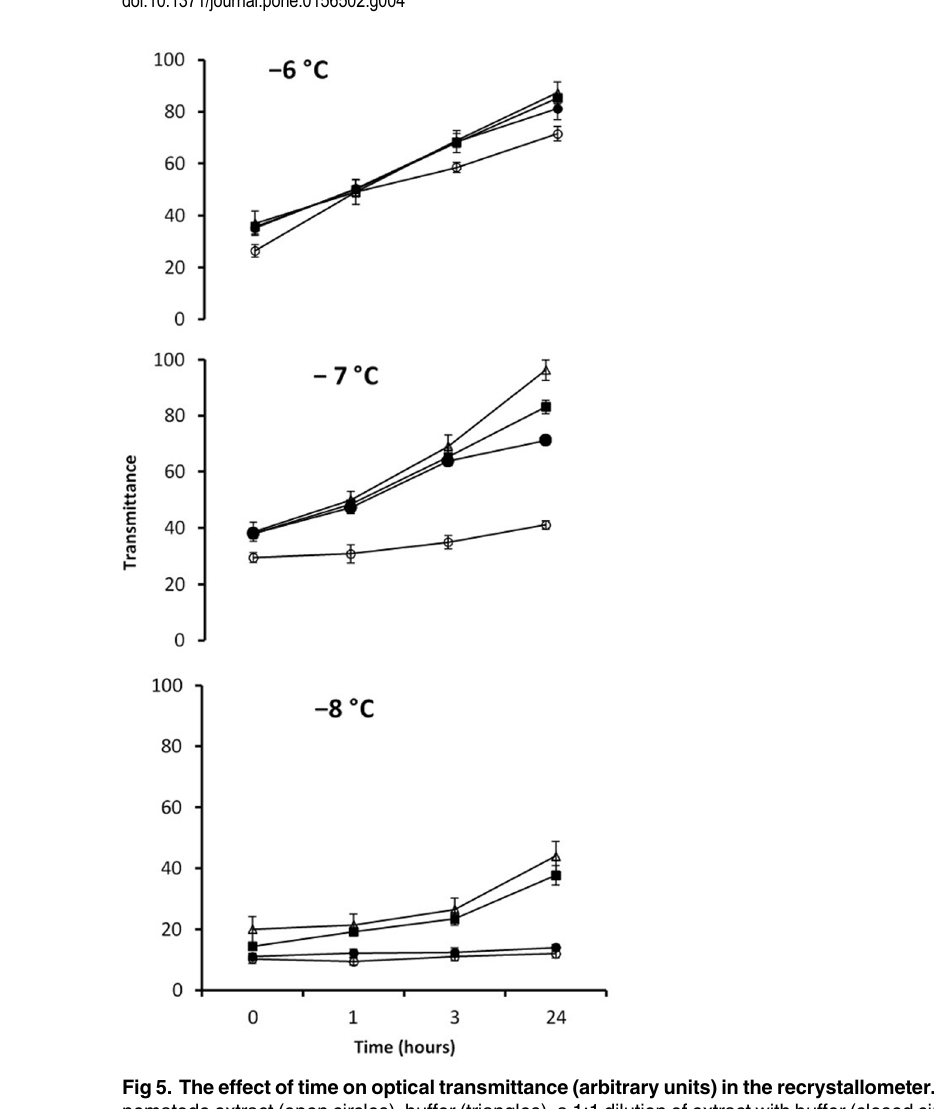
Fig 4. The effect of temperature on the ice crystal size of the nematode extract after heating at various temperatures for 1 hr. Means ± SD, N = 3.